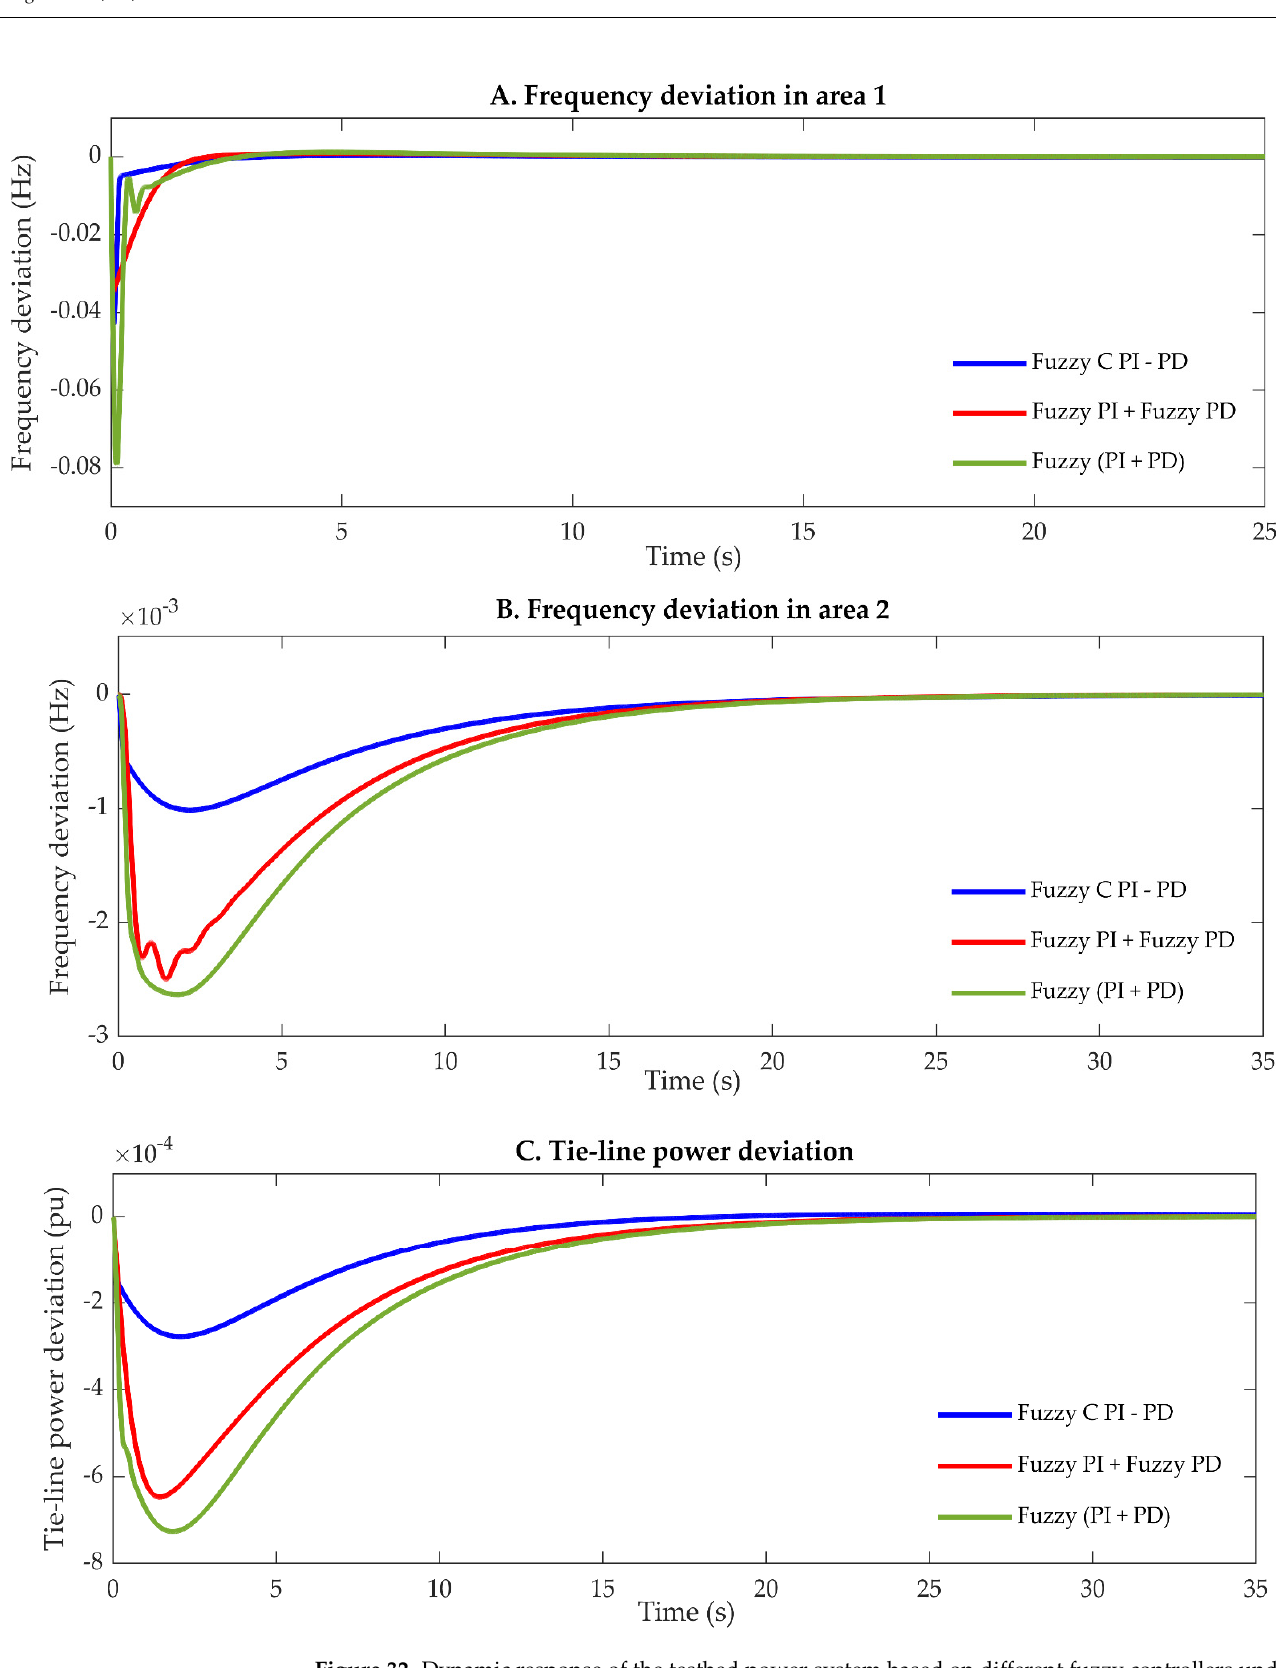
Figure 32. Dynamic response of the testbed power system based on different fuzzy controllers under parametric uncertainty conditions, case 11. ( A ) Frequency variation in area 1; ( B ) frequency variation in area 2; ( C ) tie-line power variation.